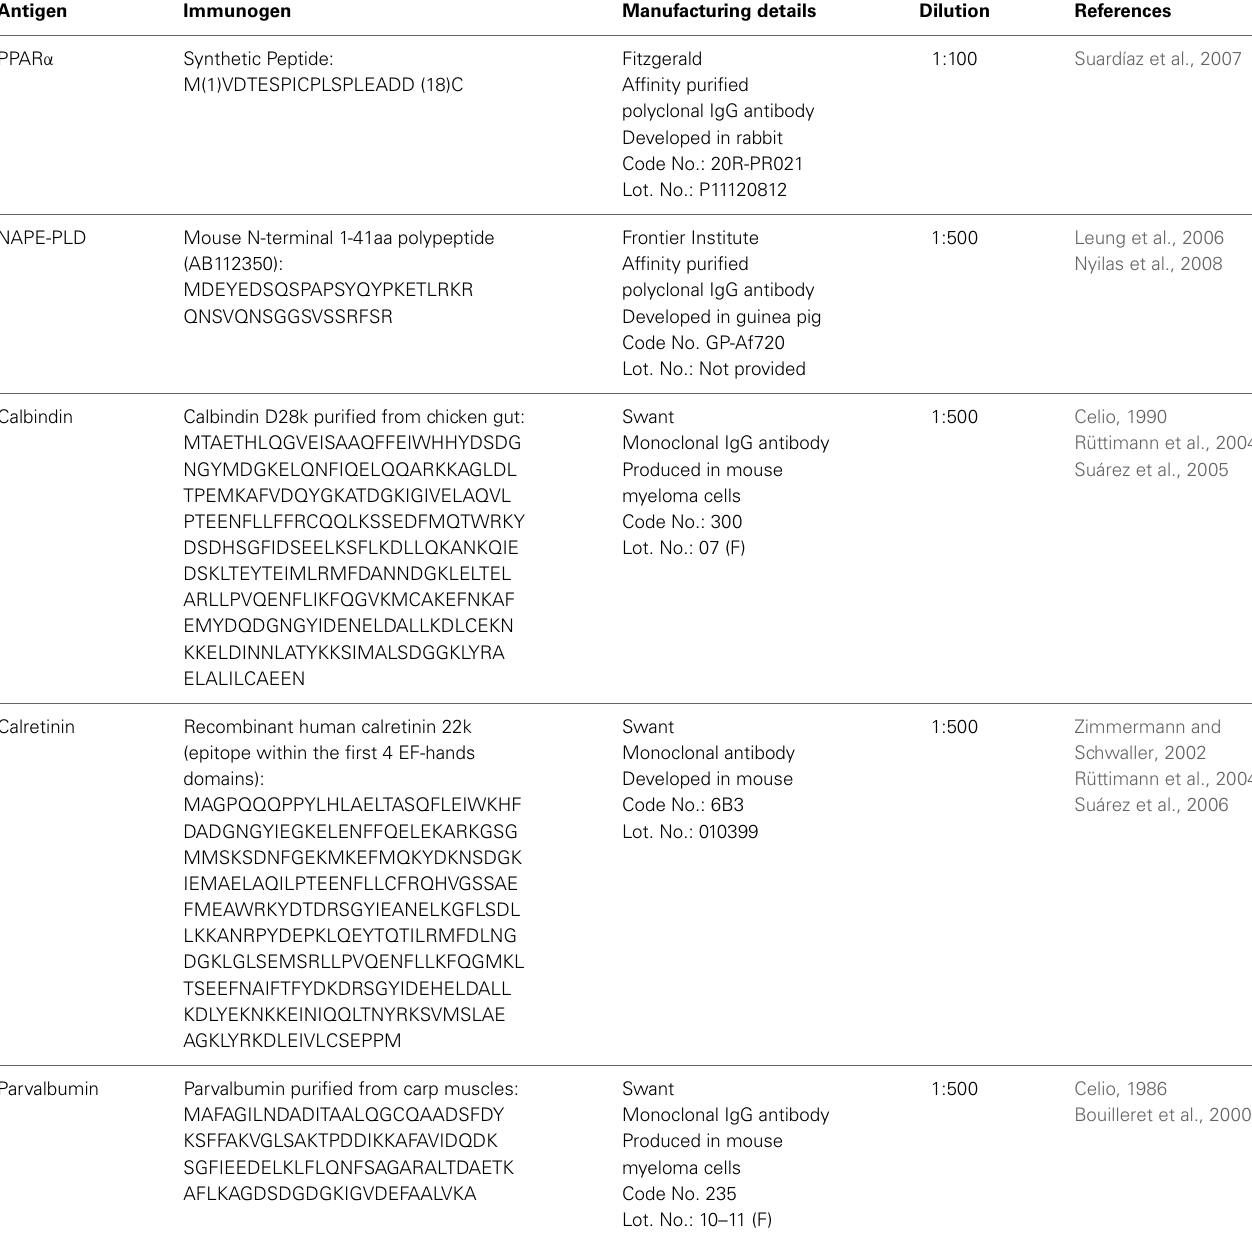
Table 1 | Primary antibodies